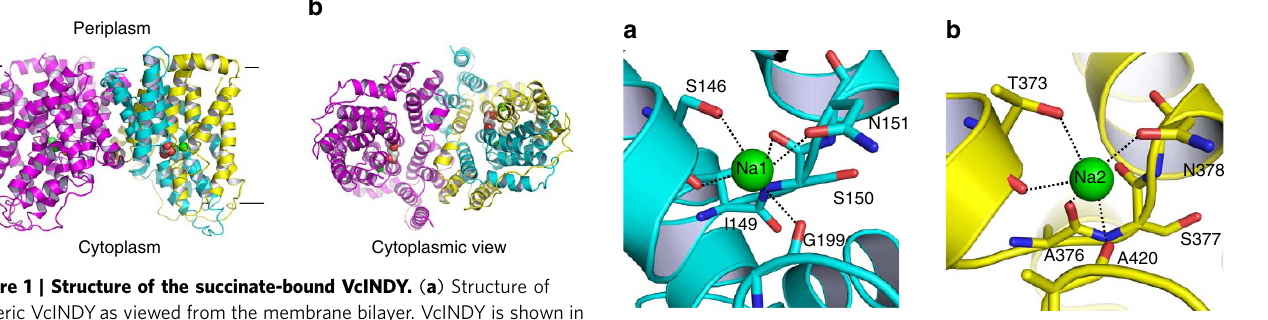
Figure 2 | Close-up views of the Na þ -binding sites in VcINDY. ( a ) Structure of the Na þ -binding site in the N domain. ( b ) The previously unobserved Na þ -binding site within the C domain. Na þ ions are drawn as green spheres and relevant amino acids as stick models. Dashed lines indicate the coordination